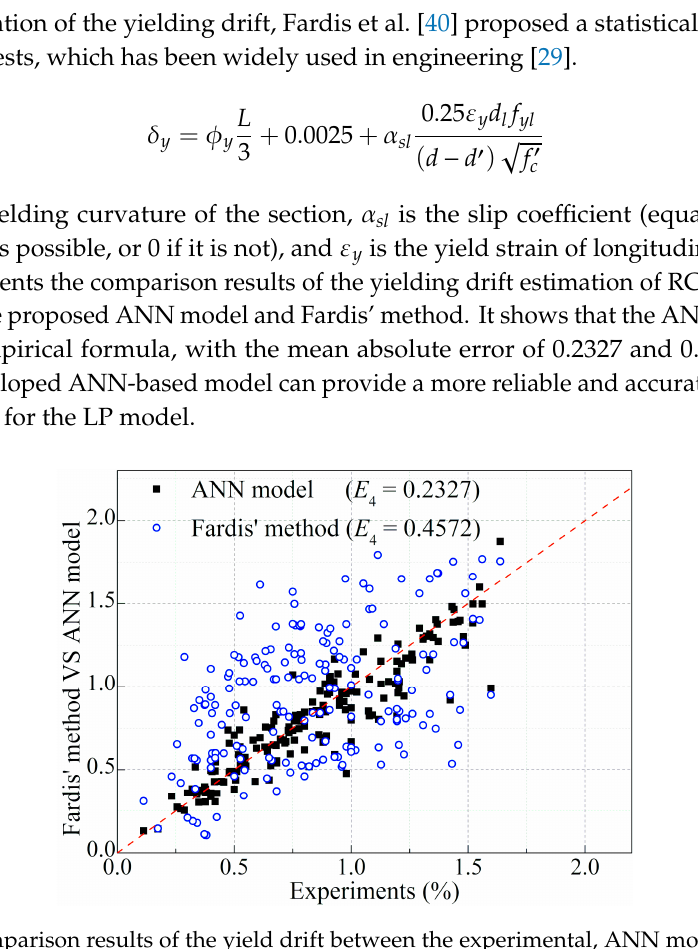
Figure 11. Comparison of experimental results of the yielding drifts and predicted results from the ANN model.